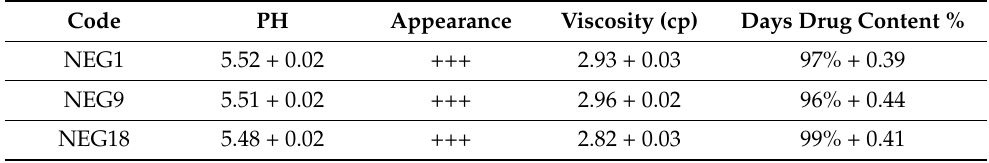
Table 7. Stability study of TAM-NEGs over 30 days.